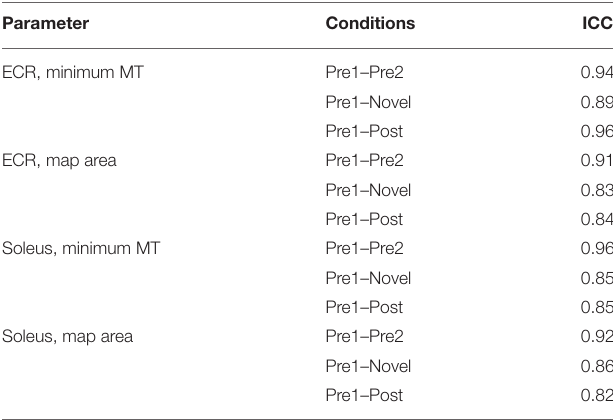
TABLE 1 | Intra-class correlation representing the test-retest variability of the motor map parameters. Parameter